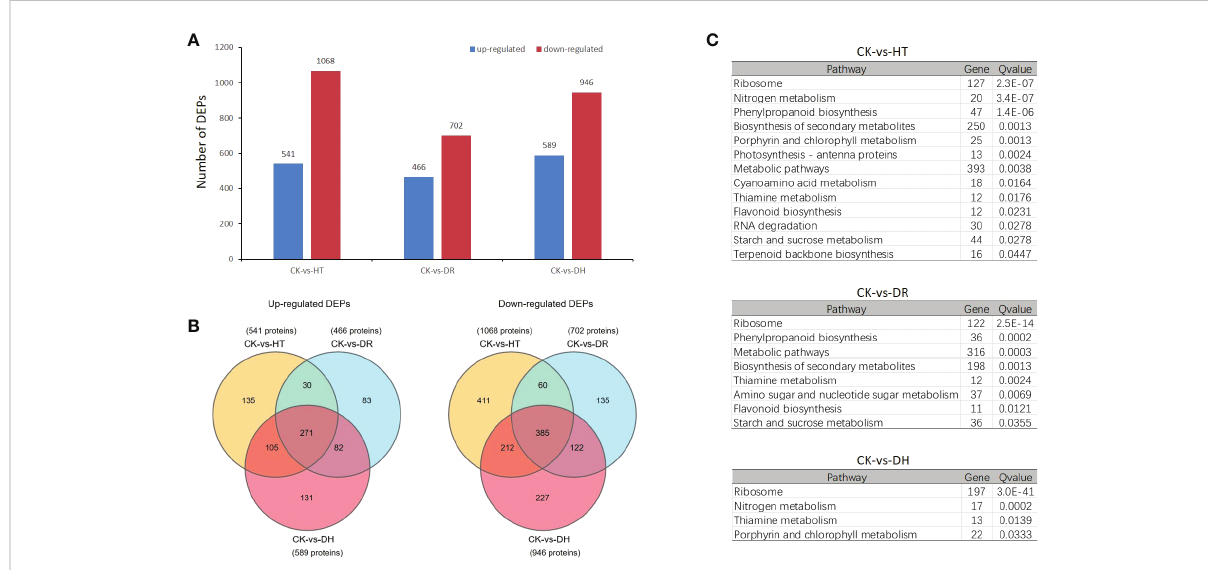
FIGURE 6 Differentially expressed proteins analysis under HT, DR and DH stresses. (A) Numbers of up- and down-regulated DEPs. (B) Venn diagrams of DEPs. Left: up-regulated DEPs; right: down-regulated DEPs. (C) KEGG pathways showing signi fi cant ( q < 0.05) DEP enrichment for each stress